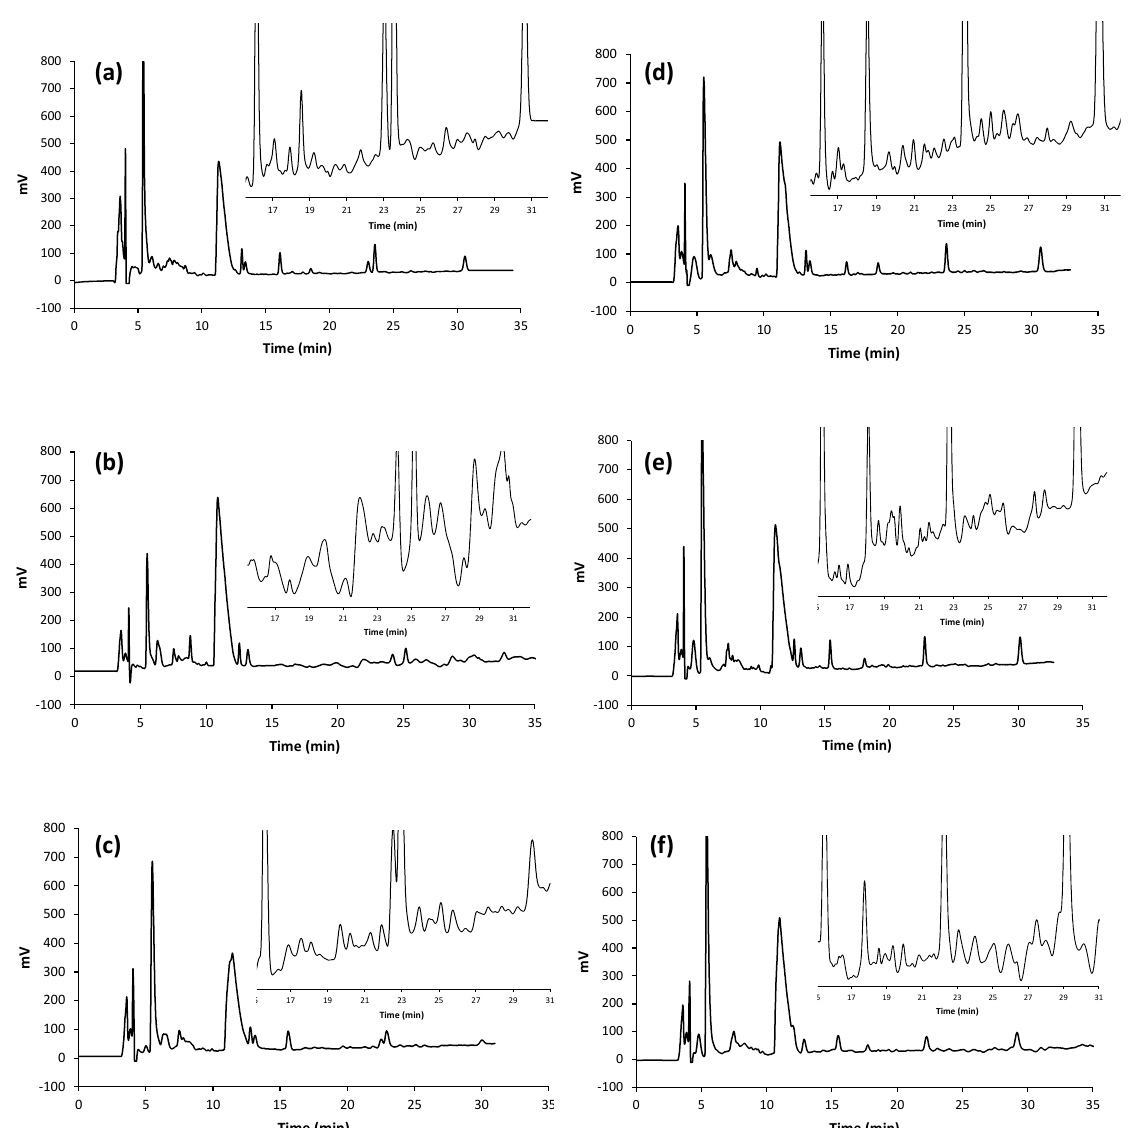
Figure 1. Chromatographic profiles obtained from SM substrate fermented with ( a – c ) L. acidophilus strain (strain LA 14) and ( d – f ) L. helveticus (LH field strain), at time points of 12 h, 72 h, and 400 h, respectively. The hydrolysates were extracted by TCA at 4 °C (see Section 2.4 for details). An enlarged portion of each chromatogram in the time-window 15–30 min is reported to evidence the richness of the chromatographic profile relatively to minor intensity detected peaks. The interference peak detected at 12 min corresponds to the TCA additive.